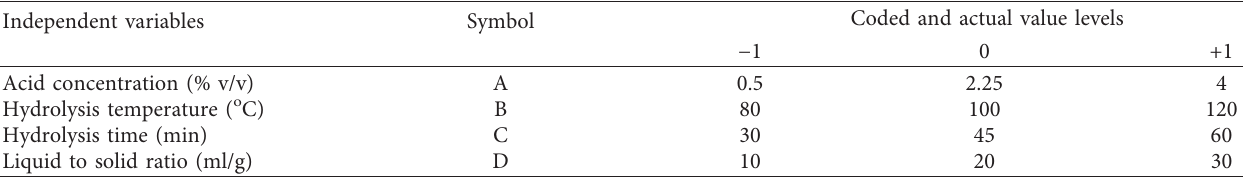
Table 1: Coded and actual value levels of the variables for Box–Behnken design.